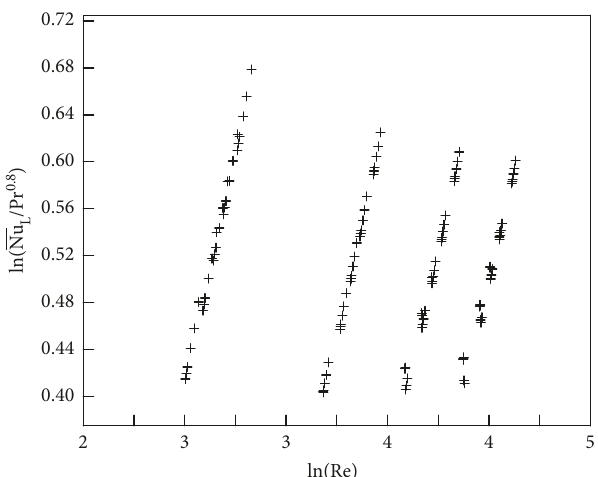
Figure 11: Average Nusselt number normalized by the Prandtl number to the power Table 2: Correlations for average Nusselt number and convective heat transfer coefficient for the microchannel PCM heat sink. � A Re B Pr C h � D Re E Pr F (W/m 2 · K) Range of the Reynolds number Nu L � 0 . 213 Re 0 . 783 Pr 0 . 800 h � 1380Re 0 . 783 Pr 0 . 800 12.23 < Re < 16.94 Nu L � 0 . 133 Re 0 . 761 Pr 0 . 800 h � 856 Re 0 . 761 Pr 0 . 800 24.13 < Re < 32.00 Nu L � 0 . 116 Re 0 . 713 Pr 0 . 800 h � 745 Re 0 . 713 Pr 0 . 800 36.12 < Re < 47.14 Nu L � 0 . 114 Re 0 . 668 Pr 0 . 800 48.11 < Re < 62.29 Nu L